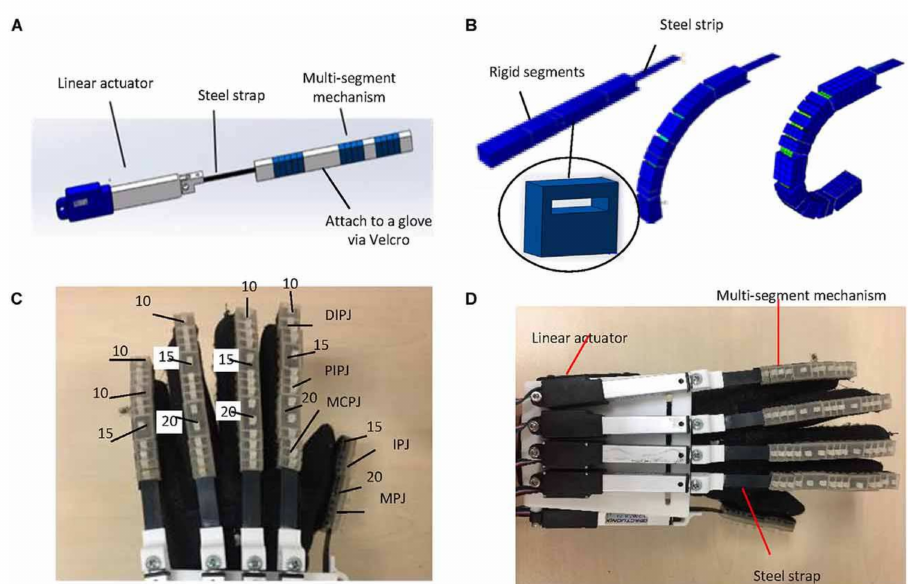
Figure 7. An attention-controlled hand exoskeleton. ( A ) CAD drawing of the index finger acuator; ( B ) bending motion generated by the proposed mutli-segment mechanism with a spring layer; ( C ) segment thicknesses (unit: mm); and ( D ) overview of the hand exoskeleton prototype [47].